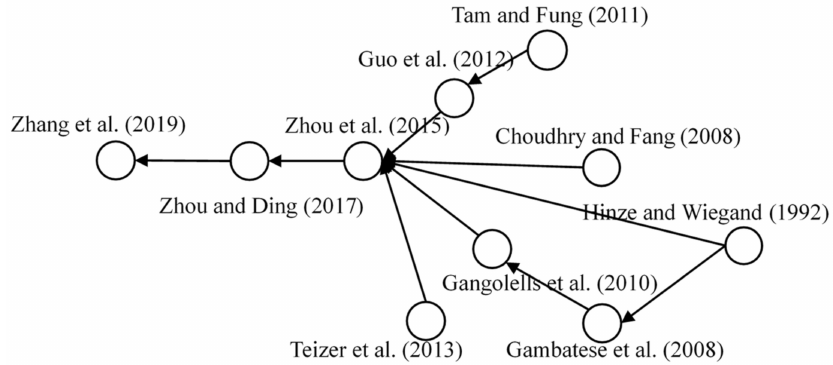
Figure 8. Main path of safety